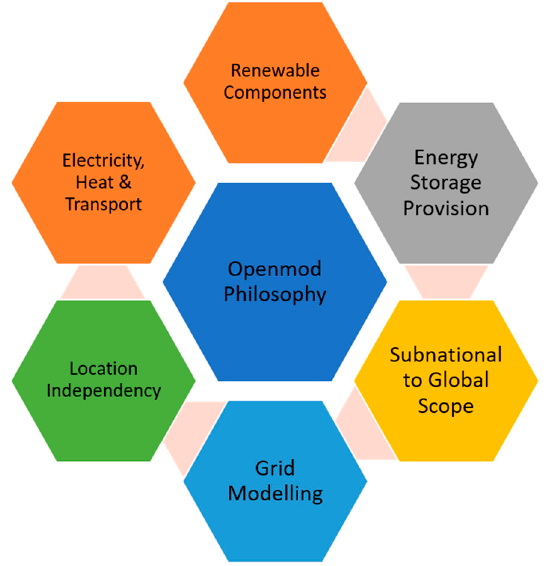
Figure 7. The rationales used for selecting tools to design a sector ‐ coupled renewable energy sources (RES) ‐ based system.